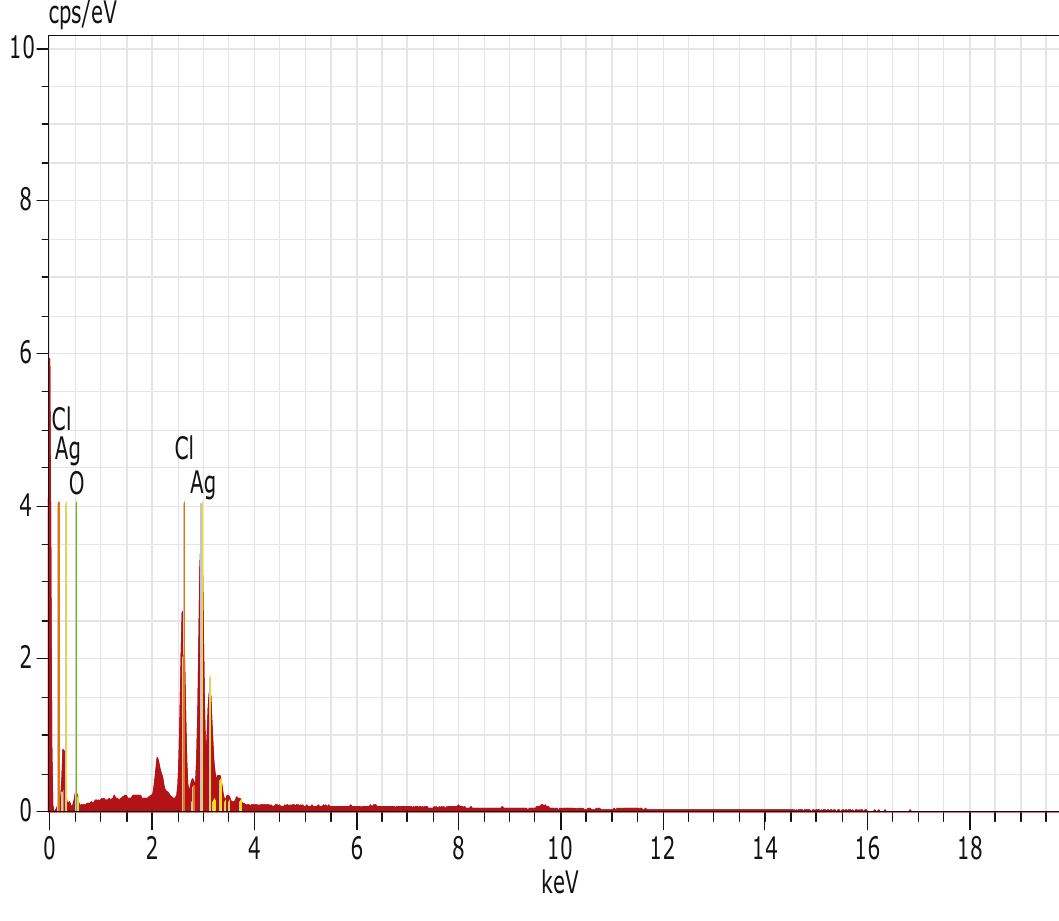
Figure 4: EDX spectrum of Z. mays silk - fabricated AgNPs.